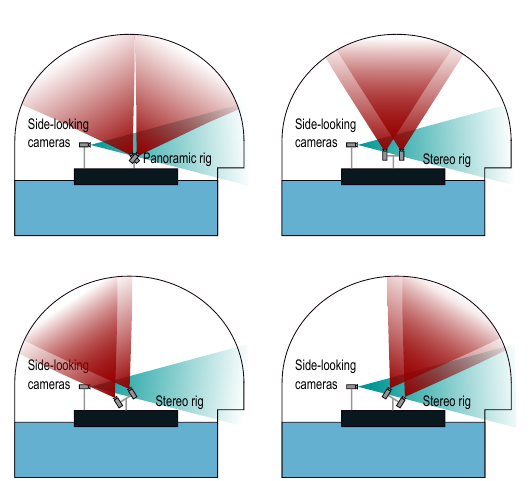
Figure 4: Schematic view of the tunnel and the barge featuring the camera configurations. Top left: panoramic, top right: stereo ( 0 ◦ ) , bottom left: stereo ( 32 ◦ ) and bottom right: stereo ( − 32 ◦ ). the barge. Vertical tubes are fixed on the frame, to support pro-